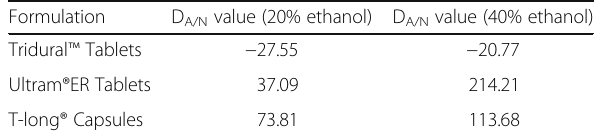
Table 4 D A/N values of tramadol from Tridural ™ Tablets, Ultram®ER Tablets, and T-long® Capsules after 4 h in 20 and 40% ethanolic media (data from reference (Traynor et al. 2008)) Formulation